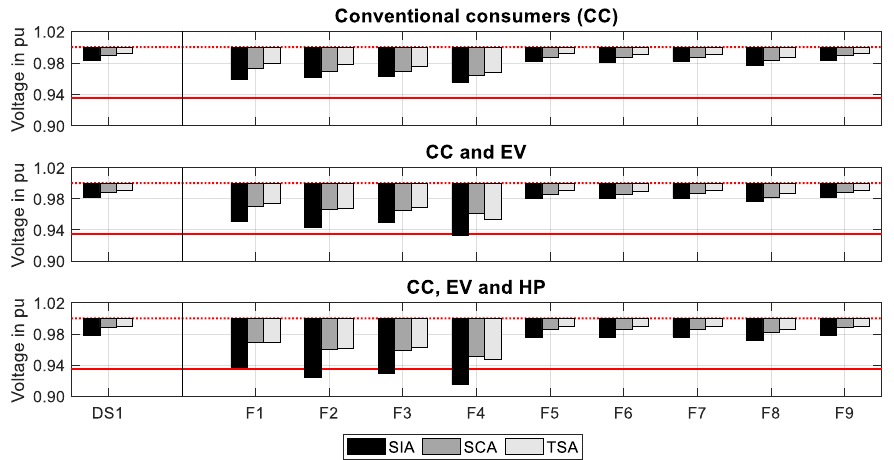
Figure 6. Comparison of various load approaches regarding voltage deviations at the distribution substation (DS1) as well as at feeders (F1–F9) considering an EV- and HP-penetration of 5% supplied by the suburban LV grid.